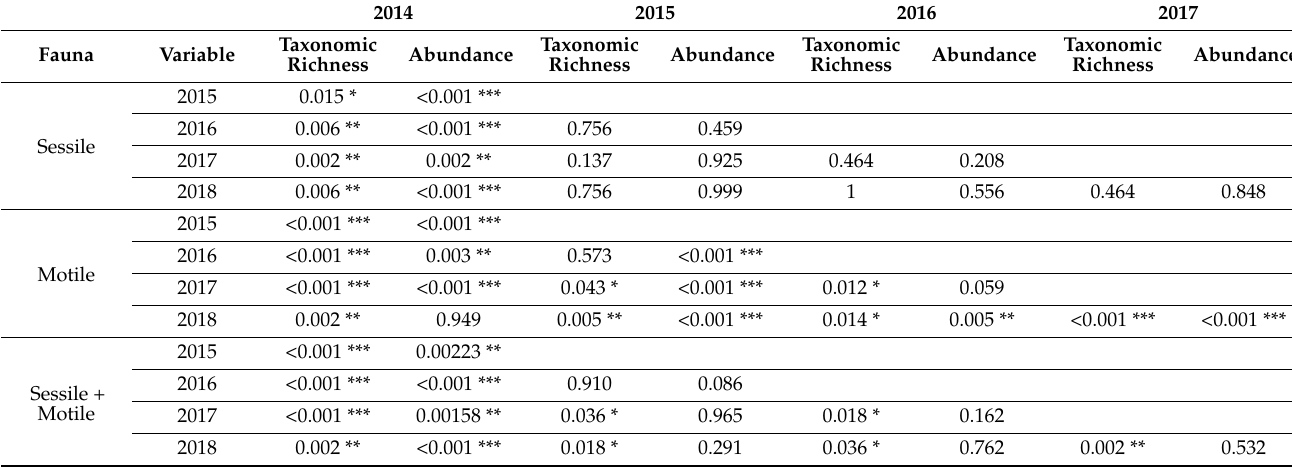
Table 3. Results of the ANOVA test corresponding to with the interaction effect of the year on the motile fauna found on the ten blocks sampled from 2014 to 2018 for Taxonomic Richness and the abundance per 0.6 m 2 .* significant to 5%; ** significant to 1% and *** significant to